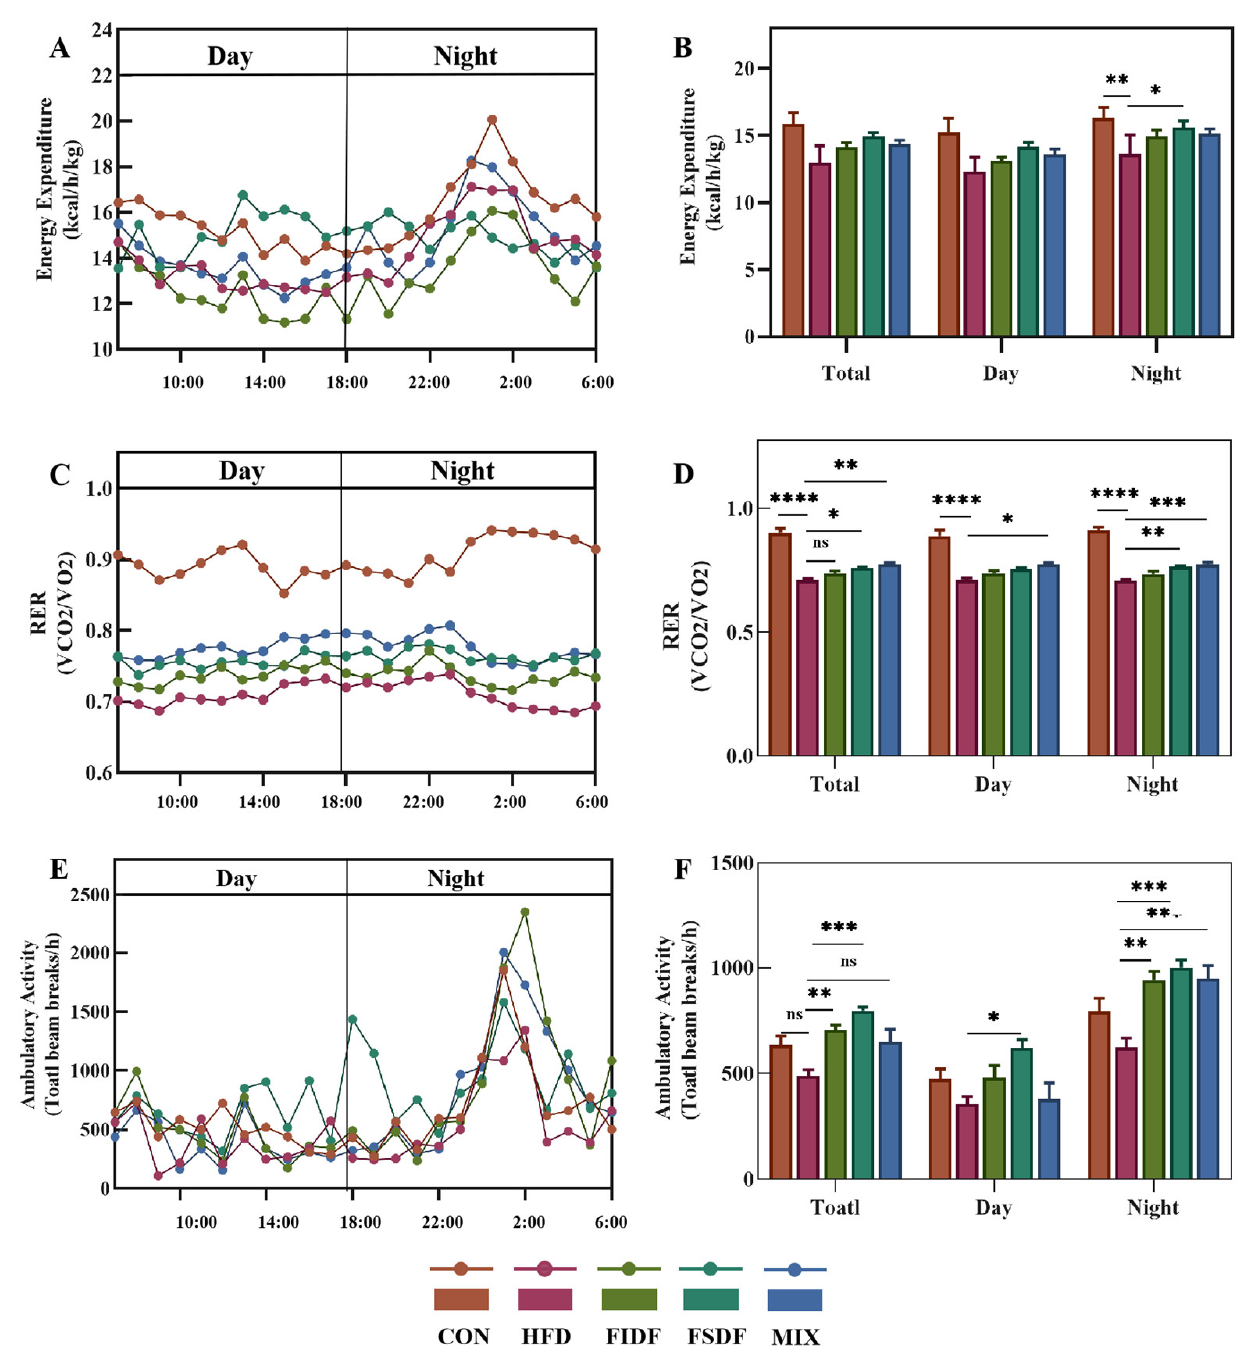
Figure 4. Effects of FIDF and FSDF on basal metabolism. The mice’s basal metabolism was measured by housing the mice in a twelve-chamber Comprehensive Laboratory Animal Monitoring System and using indirect calorimetry. ( A ) The 24 h light–dark cycle energy expenditure. ( B ) Total, light, and dark energy expenditure. ( C ) The 24 h light–dark cycle RER. ( D ) Total, light, and dark RER. ( E ) The 24 h light–dark cycle ambulatory activity. ( F ) Total, light, and dark ambulatory activity. CON, control group; HFD, high-fat diet group; FIDF, group supplemented with FIDF alone; FSDF, group supplemented with FSDF alone; MIX, group supplemented with FIDF and FSDF